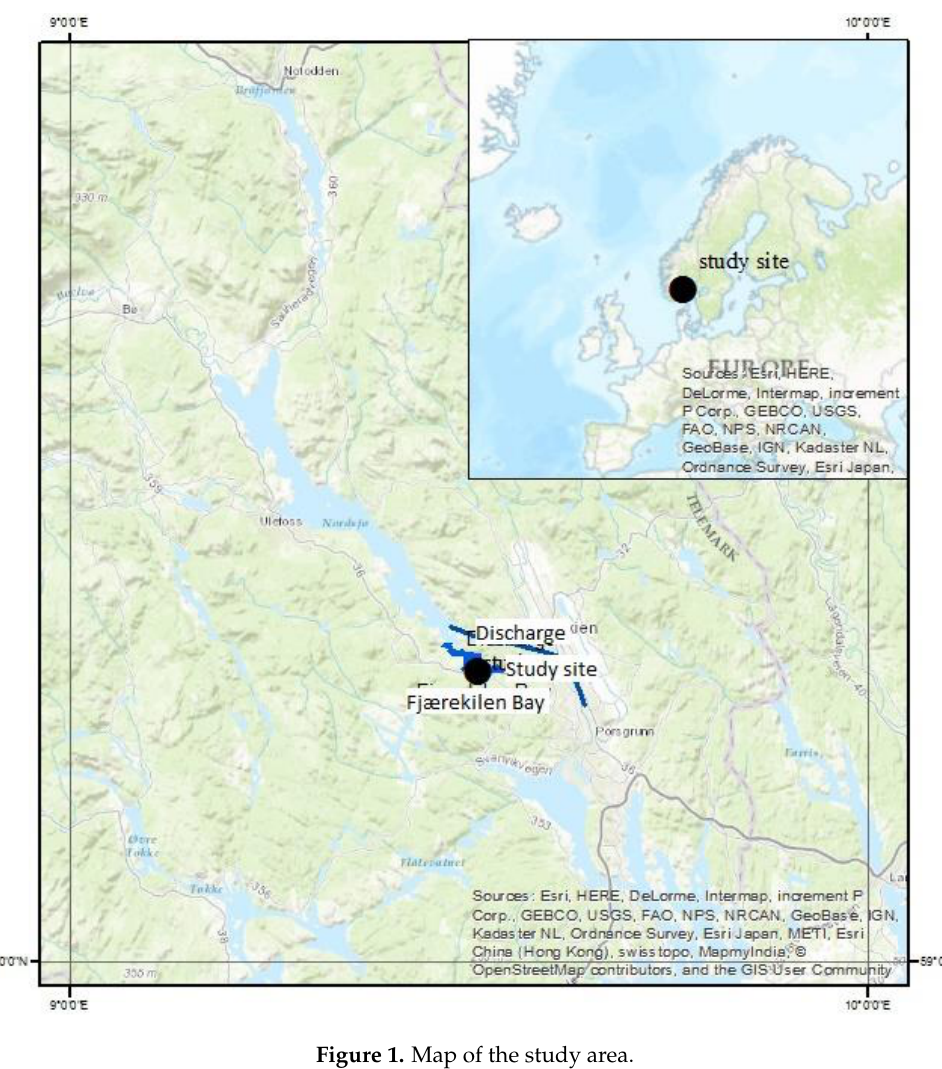
Figure 1. Map of the study area.